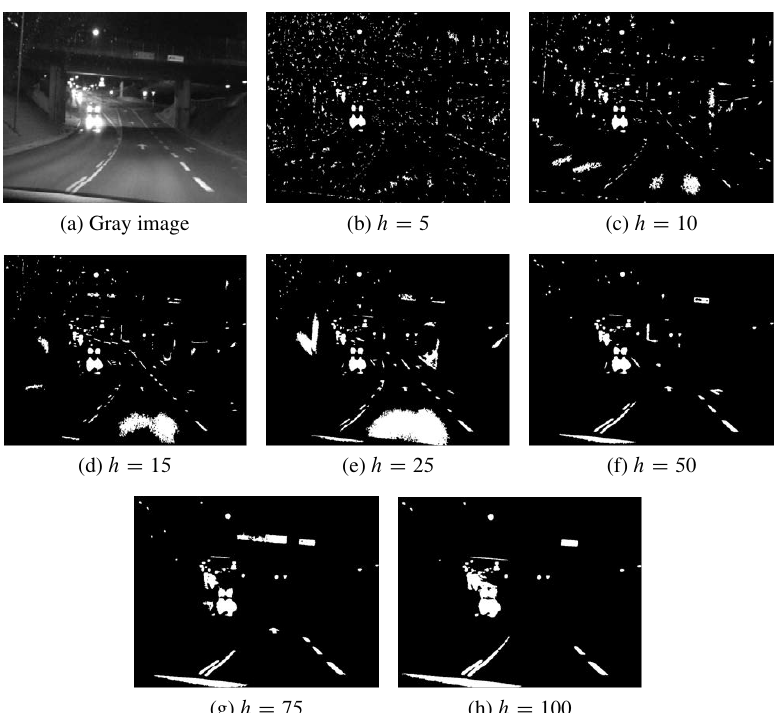
Figure 2. Segmentation with extended maxima transformation with different values of h .